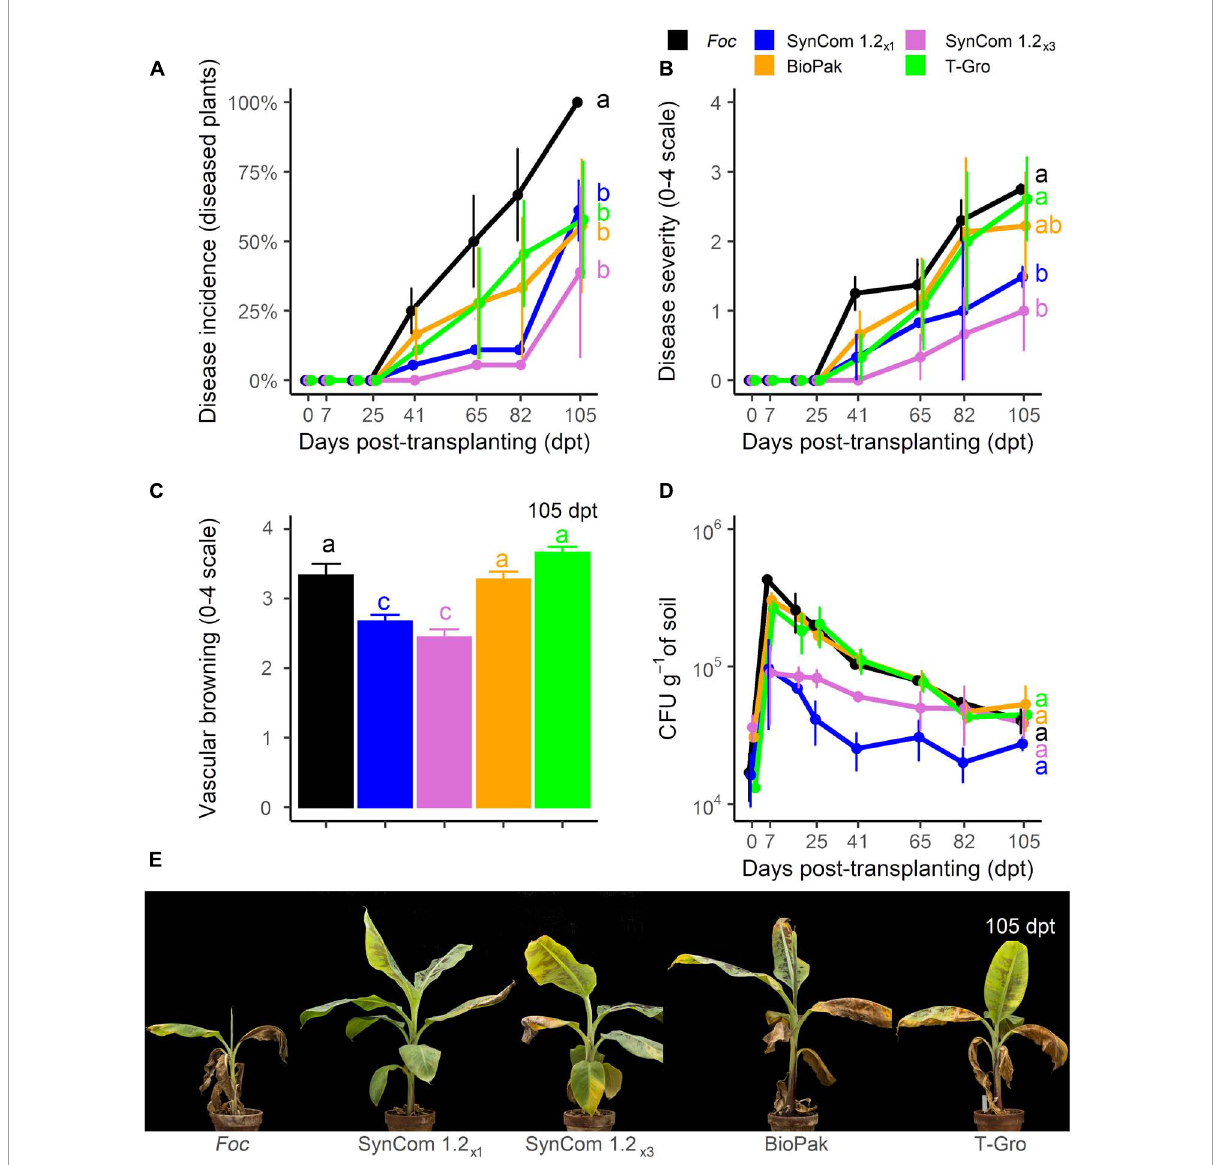
FIGURE8 Biocontrol trial D: SynCom 1.2 and commercial products. Banana plants ‘Gran Enana’ were grown in steam-sterilized soil inoculated with 10 4 CFU g − 1 soil of Fusarium oxysporum f. sp. cubense ( Foc ) tropical race 4, alone or in combination with diverse biological control agents, either experimental (i.e., SynCom 1.2, composed of three isolates, applied once, i.e., SynCom 1.2 × 1 , or three times, i.e., SynCom 1.2 × 3 ) or commercial (i.e., BioPak and T-Gro). Fusarium wilt incidence (A) , symptom severity (B) , vascular browning (C) , and Fusarium spp. soil population (D) were measured to assess the biocontrol effectiveness of SynCom 1.2. Symptoms occurring on treated and control plants are shown in (E) . Bars indicate standard error ( n = 3 in A,D , while n = 15 in B,C ). Means with different letters are significantly different according to Dunn’s test ( P < 0.05; in the line plots, means comparisons are shown only at the last time point for better readability of the graph).